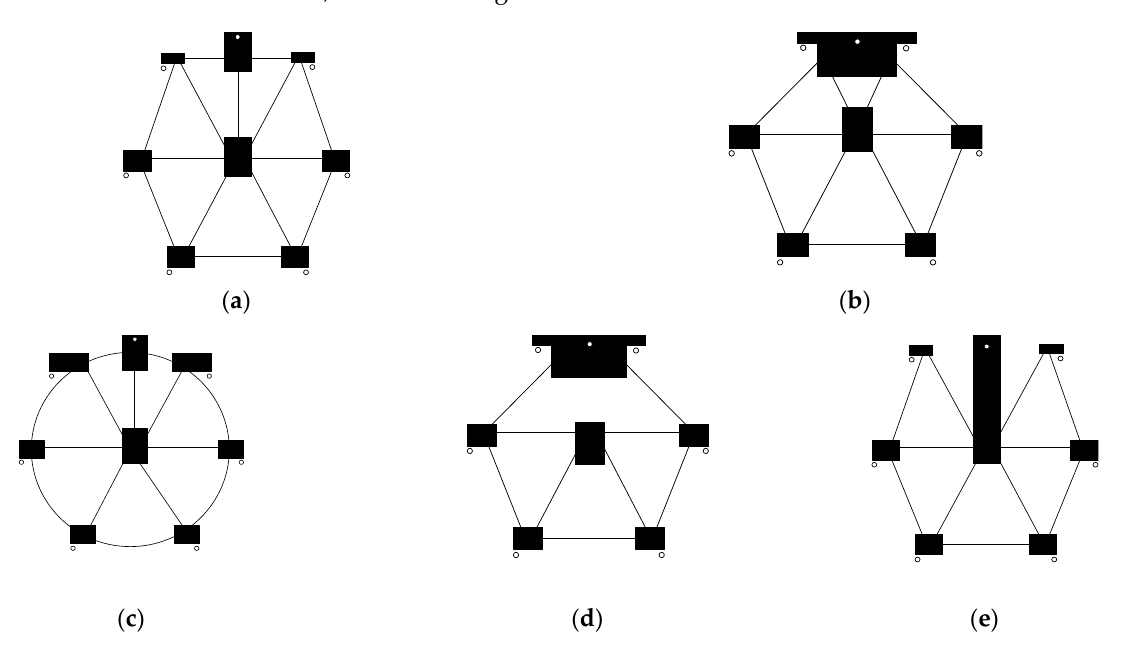
Figure 7. Conceptual design functional solutions. ( a ) Conceptual design solution 1. ( b ) Conceptual design solution 2. ( c ) Conceptual design solution 3. ( d ) Conceptual design solution 4. ( e ) Conceptual design solution 5